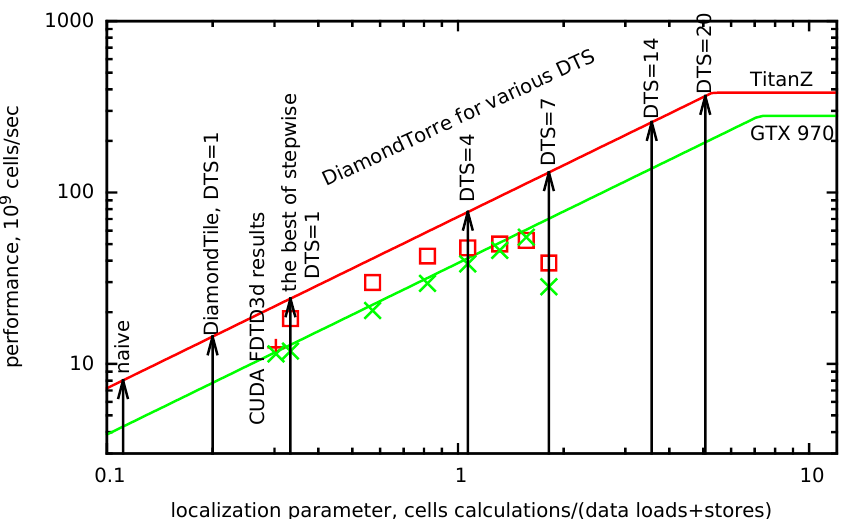
Figure 7. Roof line model for the wave equation on the